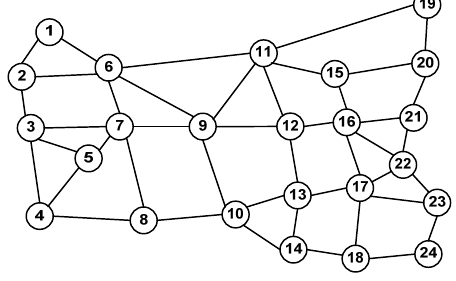
Figure 4. 24-node Figure 4. 24-node USNET.